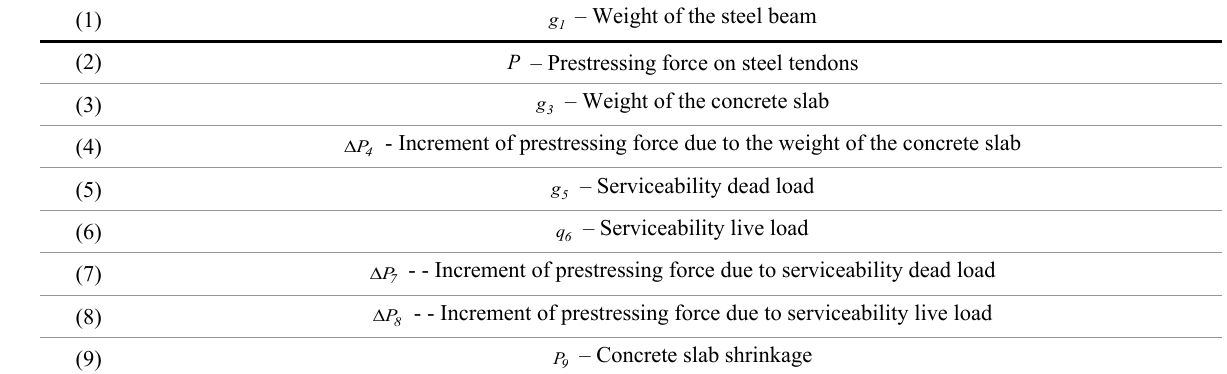
Table 1. Load considered in structural